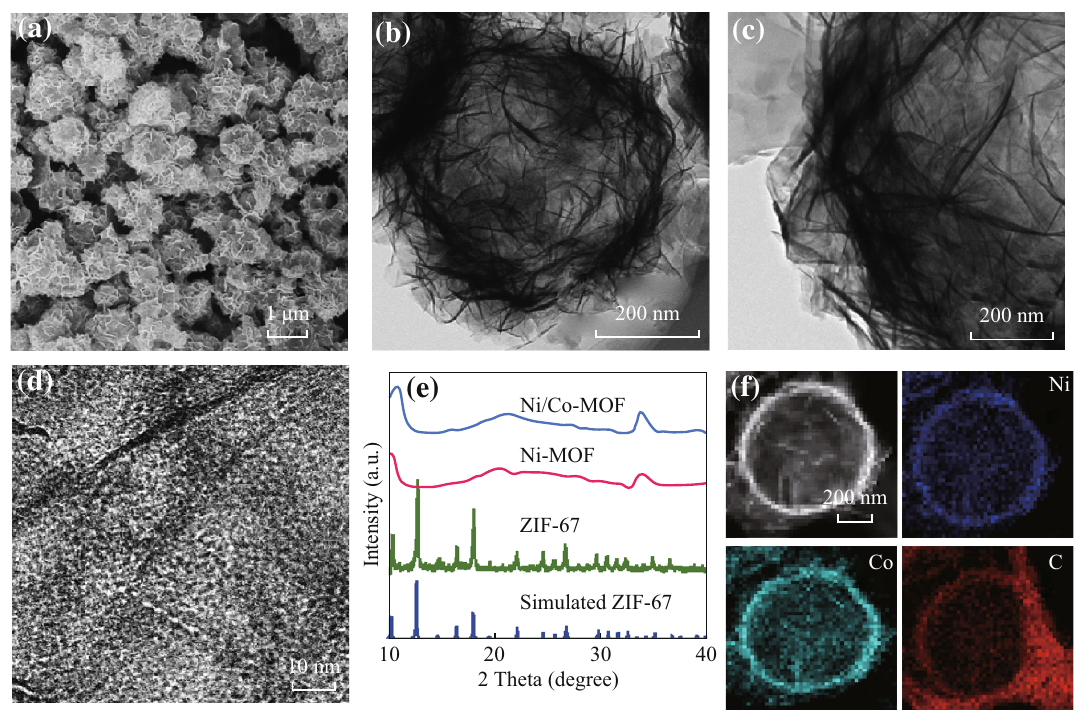
Fig. 1 a SEM images of Ni/Co-MOF nanoflakes. b , c TEM images of Ni/Co-MOF nanoflakes. d Large-magnified TEM and SAED patterns of Ni/Co-MOF nanoflakes. e XRD patterns of Ni/Co-MOF nanoflakes, Ni-MOF nanoflakes, and ZIF-67. f STEM-energy-dispersive spectroscopy (EDS) mapping of Ni/Co-MOF nanoflakes